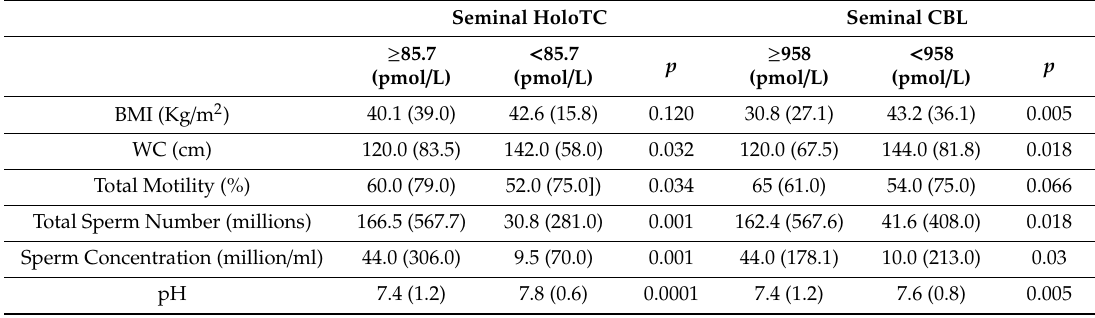
Table 5. Stratification of the whole subject cohort according to seminal holoTC and CBL cut-o ff values identified by ROC analysis. Data is reported as median (IQR) for each parameter when all subjects were stratified in two groups according to the indicated cut-o ff values of seminal holoTC and CBL identified by ROC analysis. Significant p values after the Mann–Whitney U test are